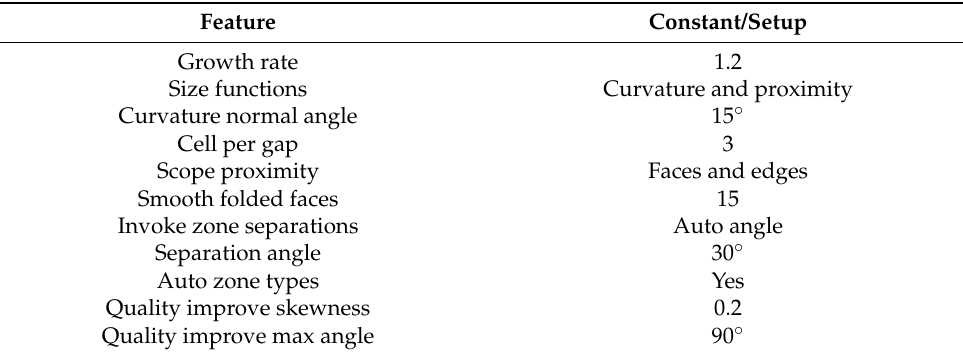
Table 2. Features used in preparation of surface